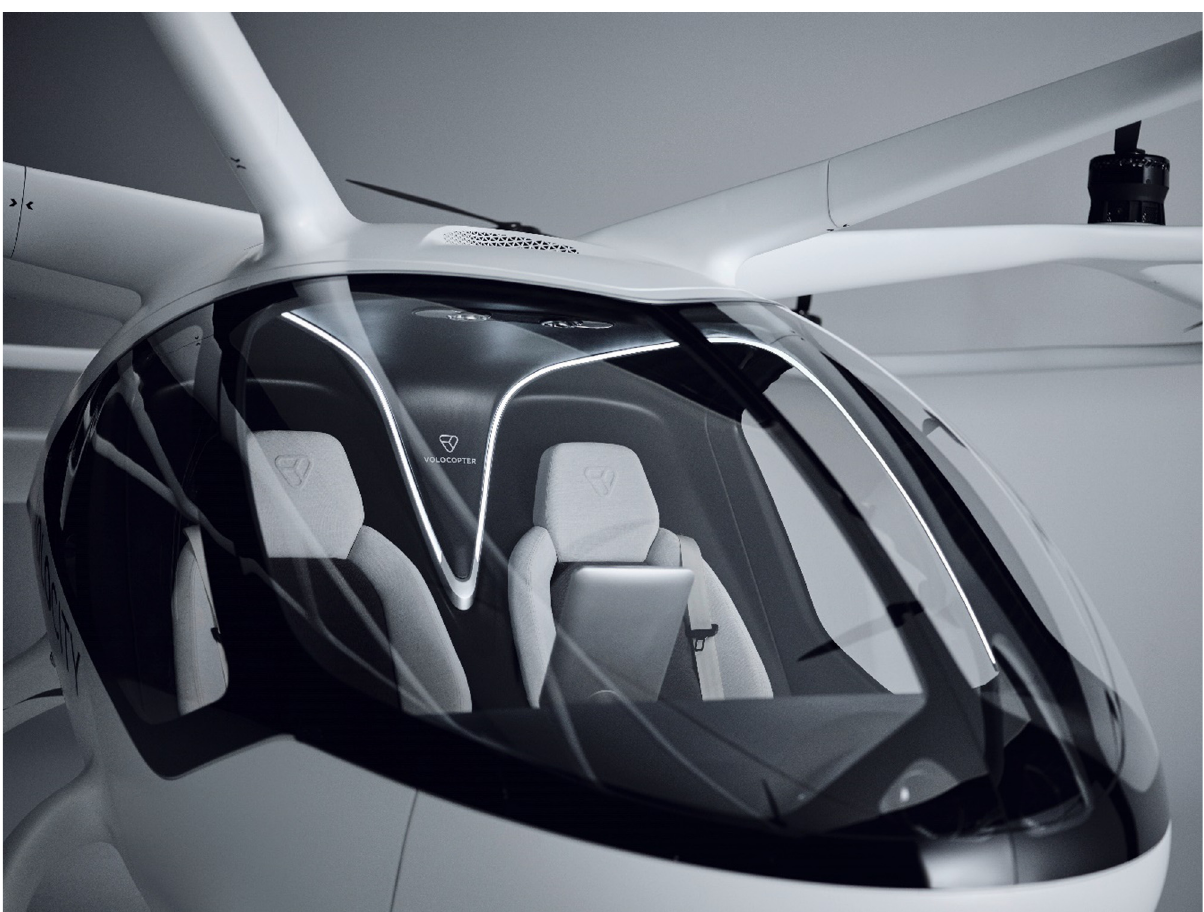
Figure 4: A real view of the cockpit of Volocopter ’ s VoloCity ( image credit: Volocopter GmbH, License ( s ) : Zur freien Verwendung – for free use, used with permission )